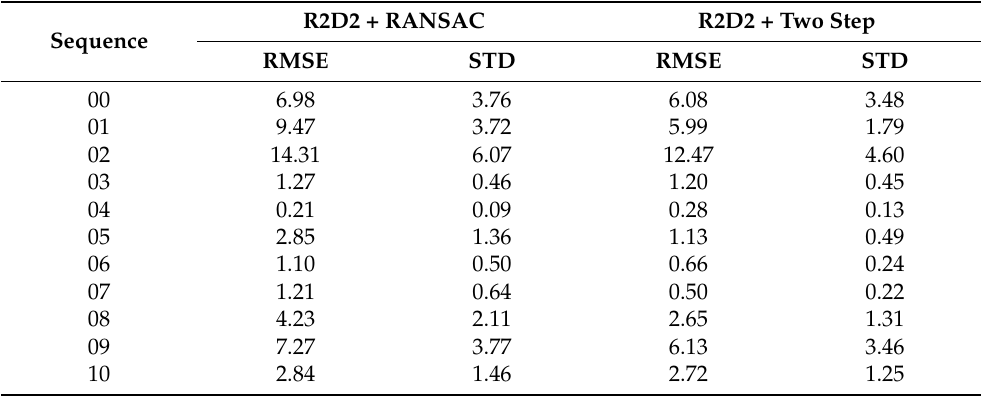
Table 2. Absolute trajectory error of two-step data association against RANSAC data association. The unit of RMSE and STD is “meters”.